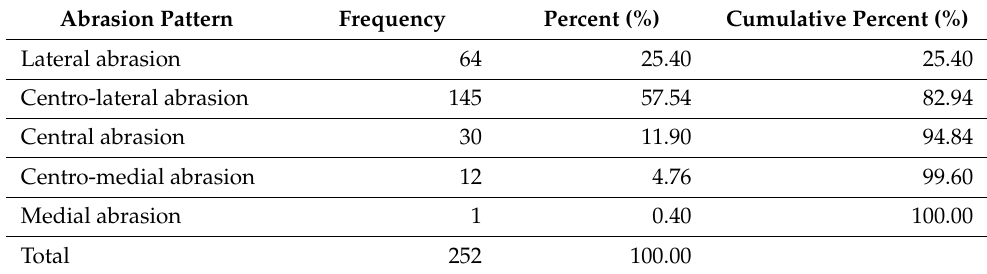
Table 6. Frequency analysis results of left shoe abrasion.